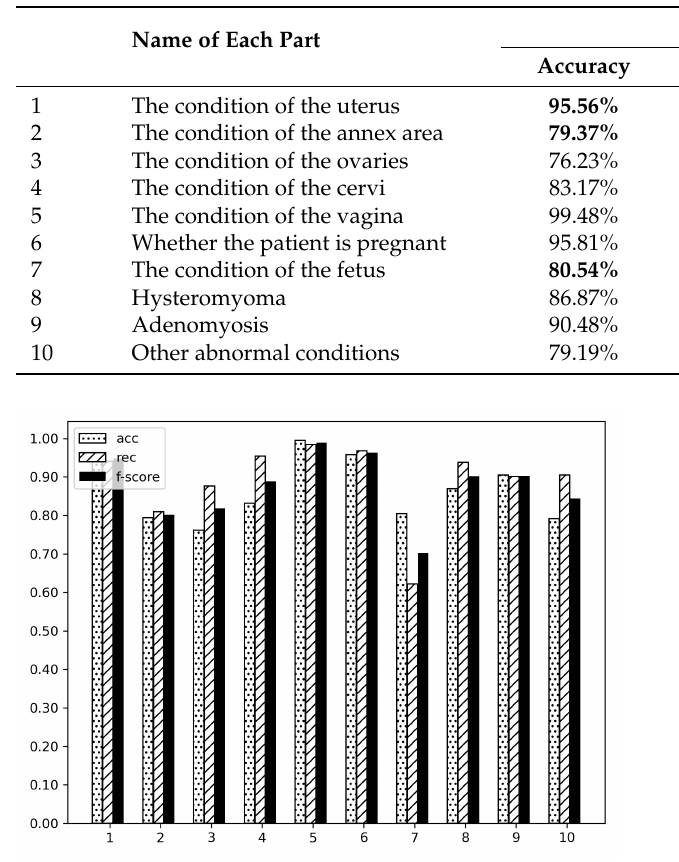
Figure 7. Accuracy, recall and F-score of IKAR for each